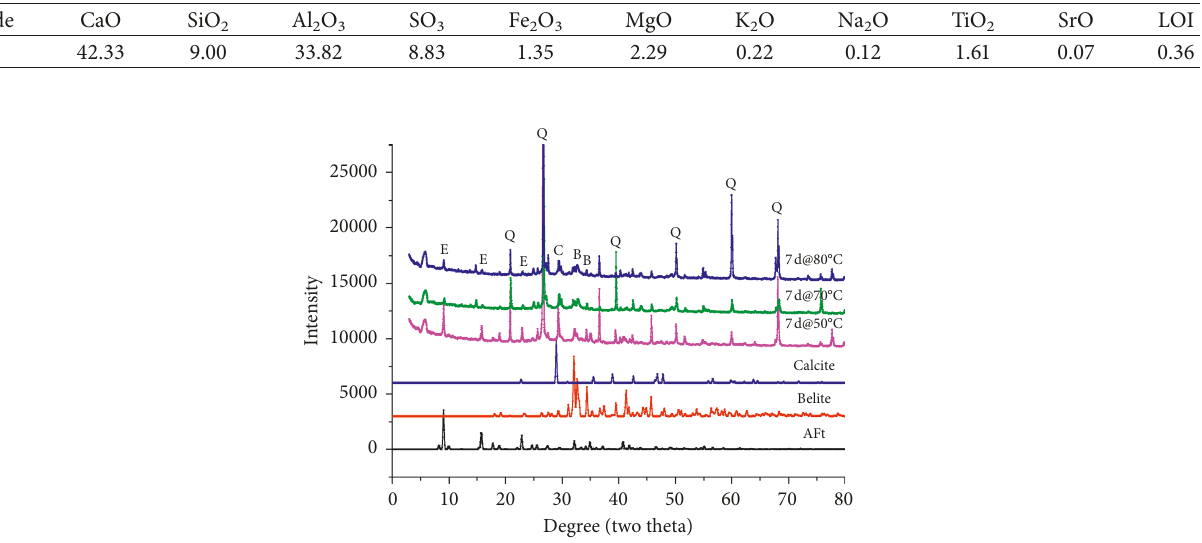
Figure 1: XRD diffraction diagram of CSA/GFRC cured at different curing regimes.